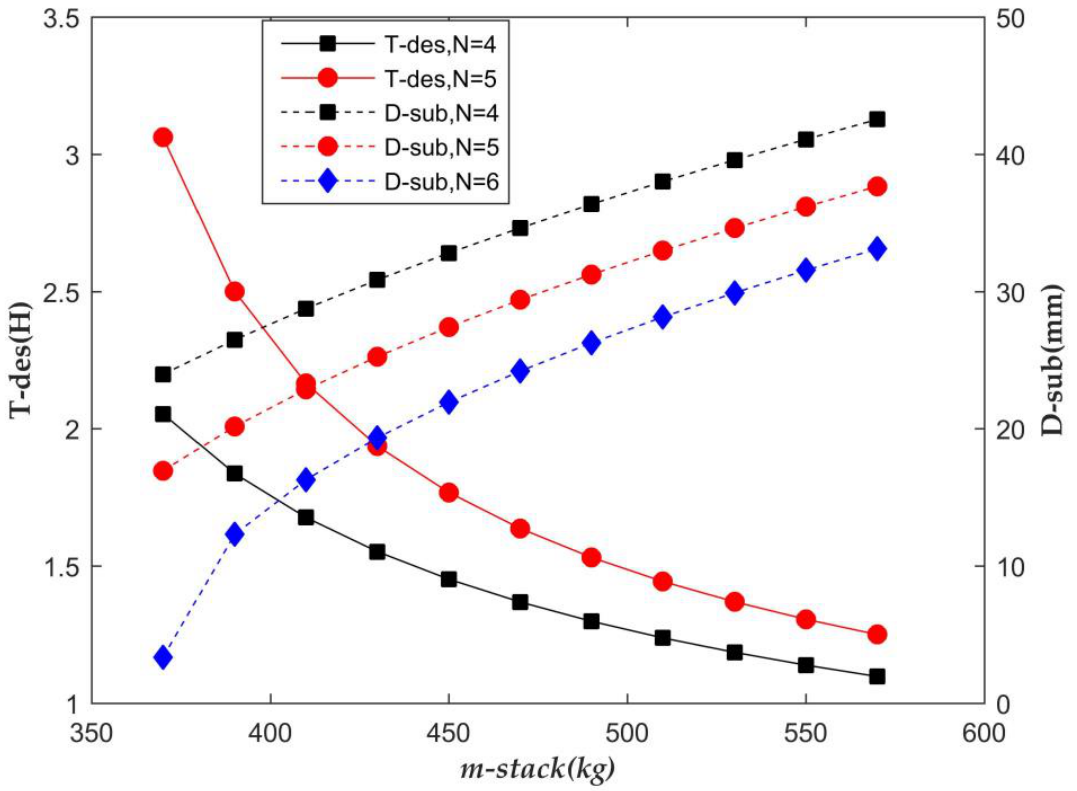
Figure 6. Subsidence depth, descent time vs. mass of the weight stack and number of floatation spheres.